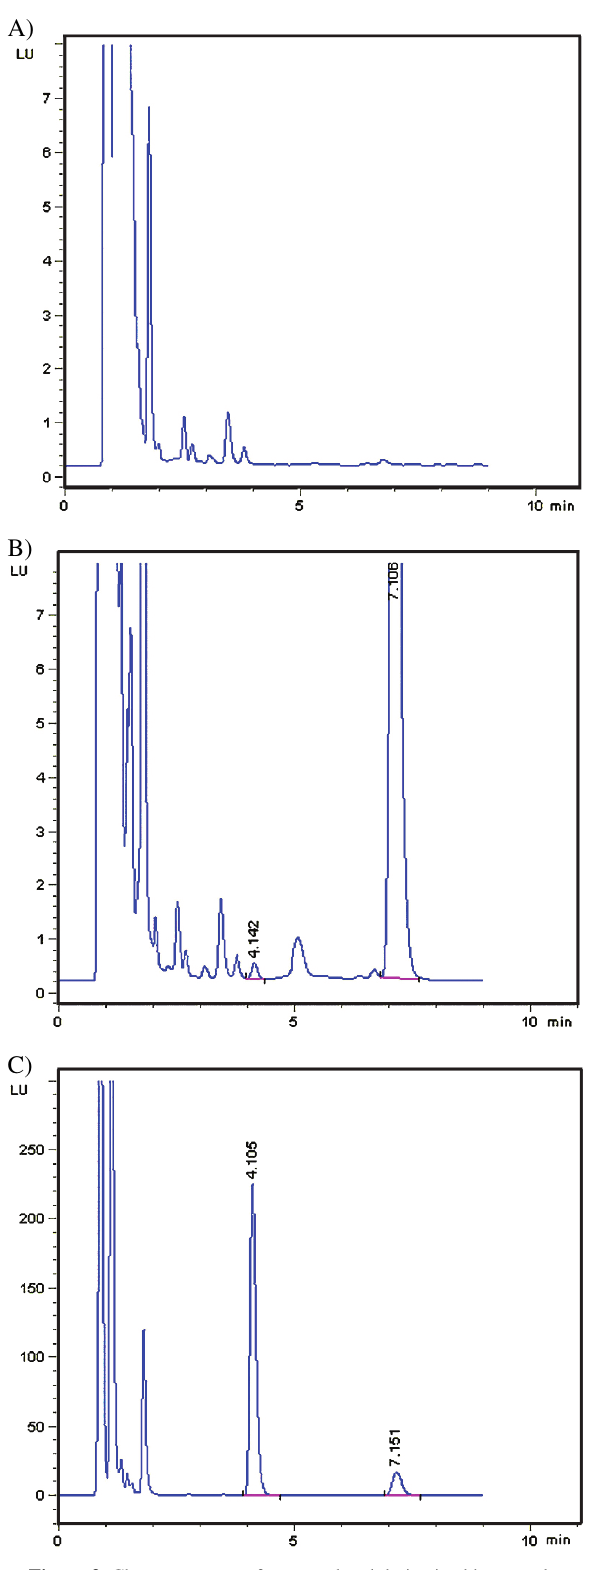
Figure 3 . Chromatograms of extracted and derivatized human pla- sma. A) blank sample; B) plasma sample spiked with TPM at 0.03 μg/mL (QCl) and C) plasma sample (9.27 μg/mL) from a patient treated with 400 mg TPM/day. Retention time of TPM and IS are 4.1 and 7.1 min, respectively.